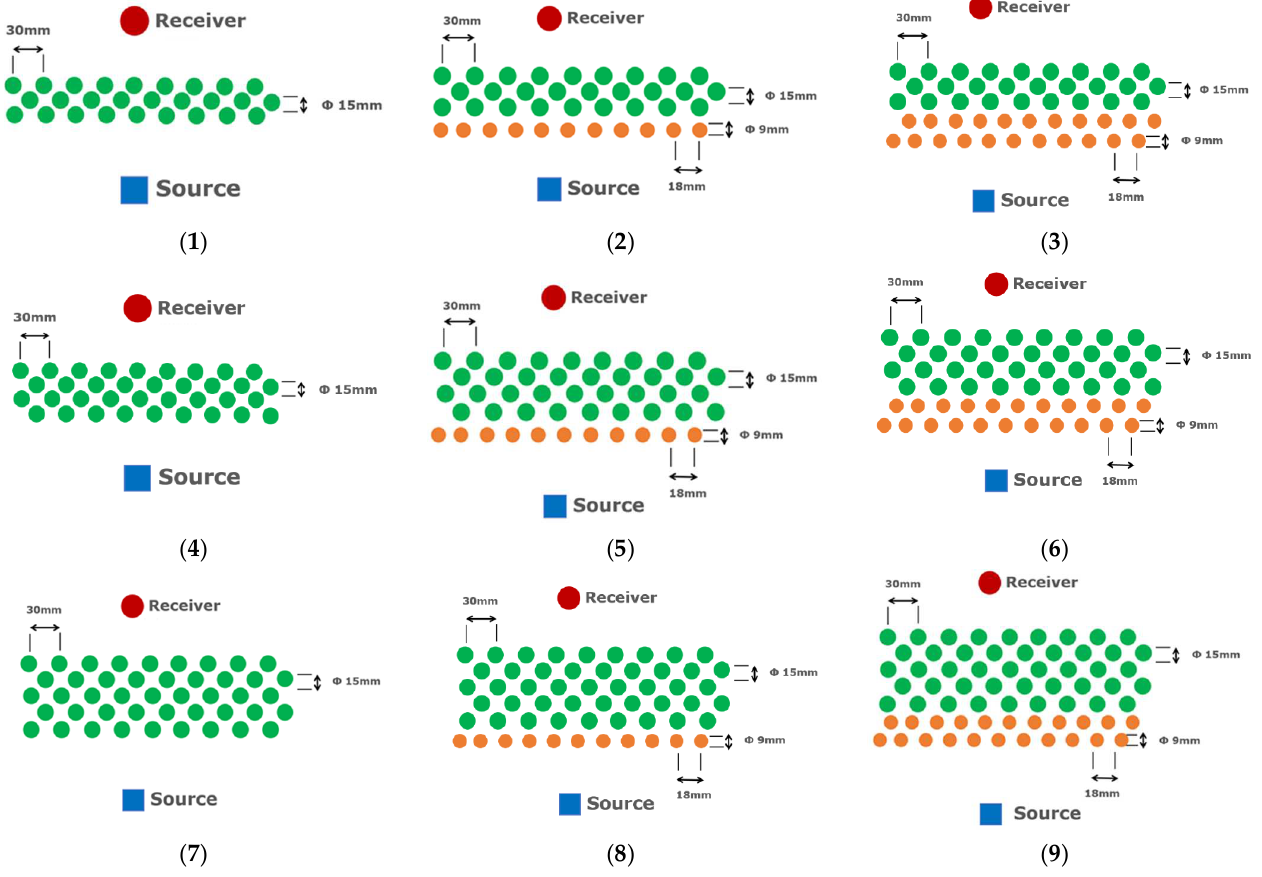
Figure 5. Out-of-scale schemes of all the configurations assumed during the acoustic measurements: 3-row type A structure ( 1 ); 3-row type A and 1-row type B structure ( 2 ); 3-row type A and 2-row type B structure ( 3 ); 4-row type A structure ( 4 ); 4-row type A and 1-row type B structure ( 5 ); 4-row type A and 2-row type B structure ( 6 ); 5-row type A structure ( 7 ); 5-row type A and 1-row type B structure ( 8 ); 5-row type A and 2-row type B structure ( 9 ).